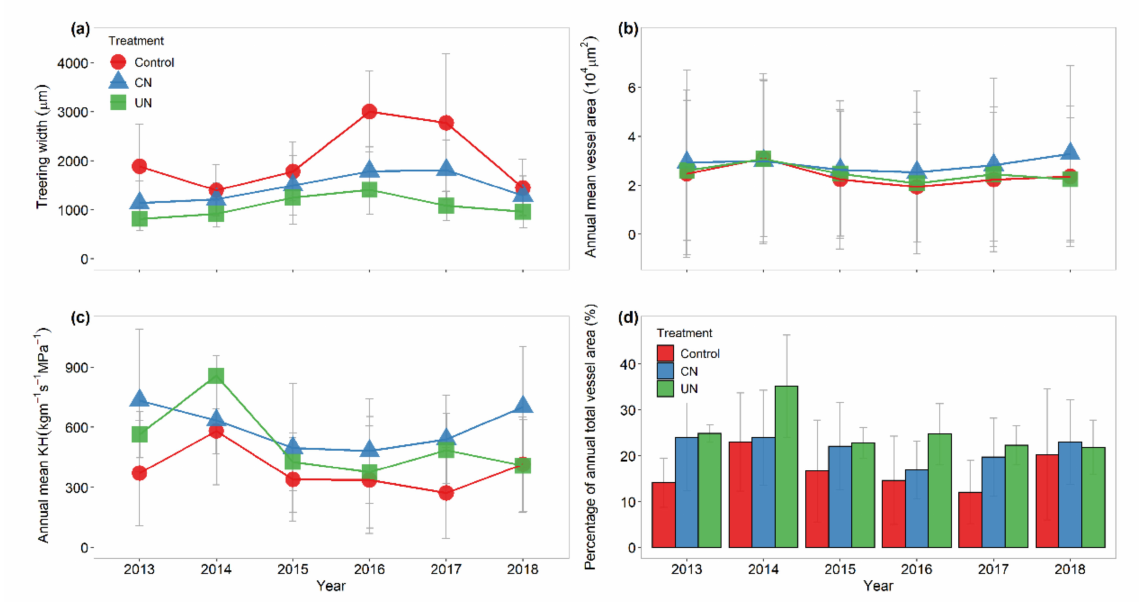
Figure 5. Tree-ring width ( a ), annual mean vessel area ( b ), annual mean KH ( c ) and percentage of annual total vessel area ( d ) of Quercus variabilis under control, canopy N addition (CN) and understory N addition (UN) treatments during 2013–2018. Error bars indicate standard